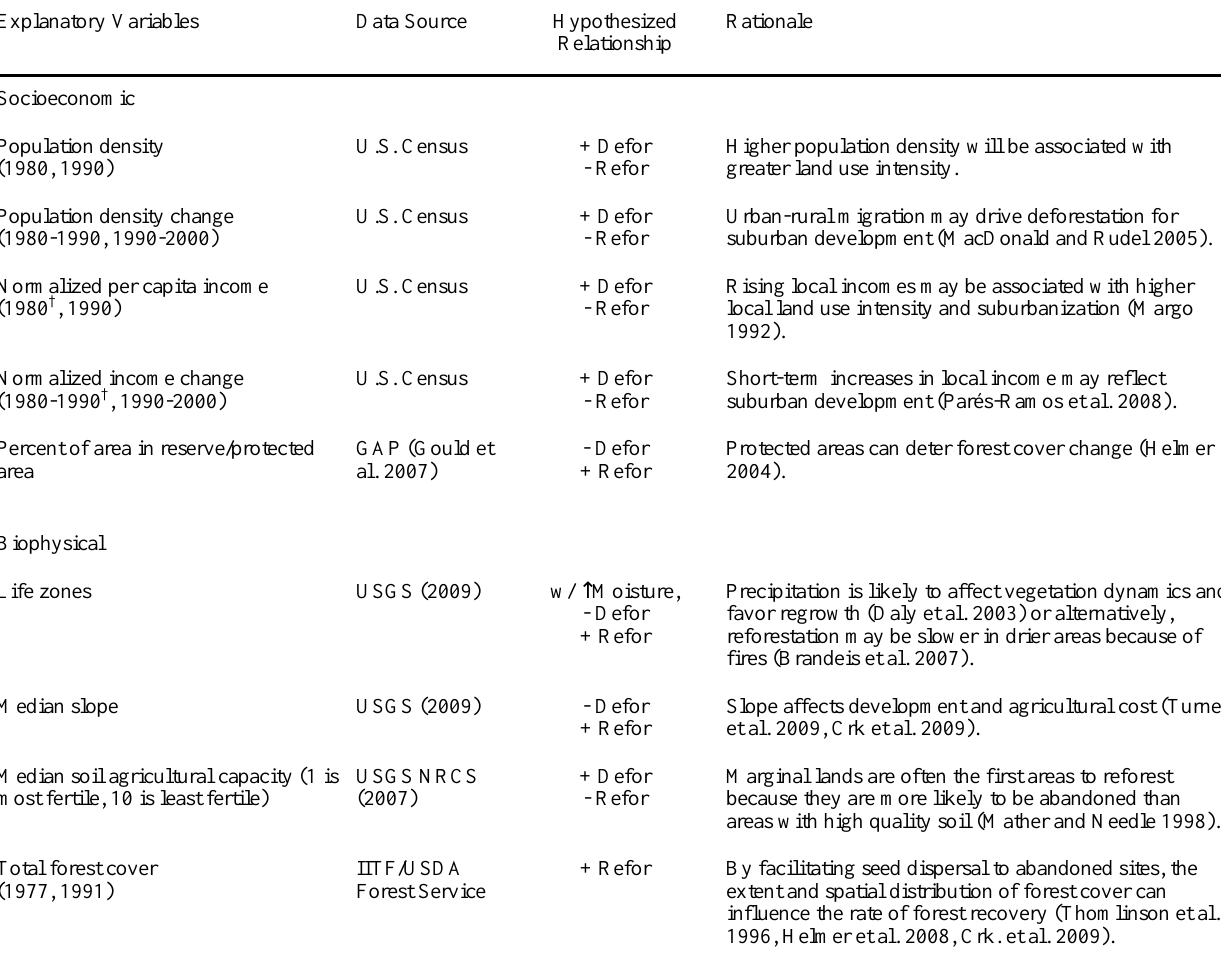
Table 1. Explanatory variables and associated hypotheses for analyses of forest change in Puerto